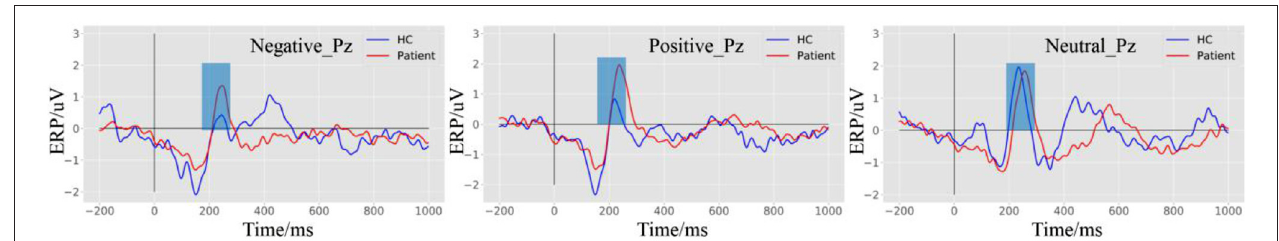
FIGURE 3 | Event-related potential (ERP) waveforms elicited by negative, positive, and neutral stimulus at the Pz electrode.